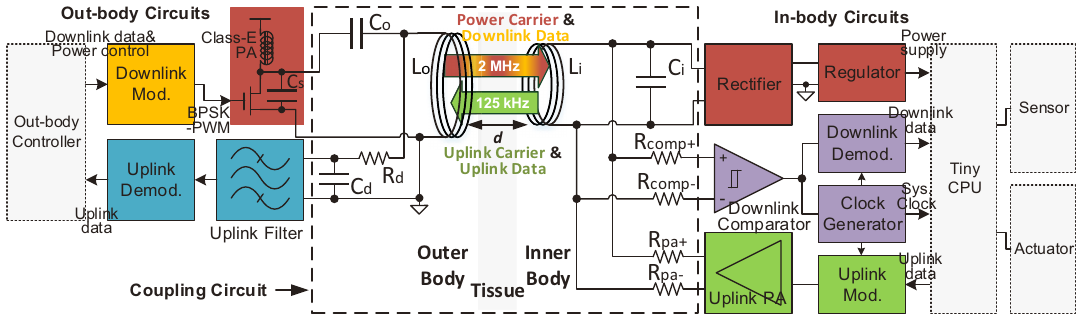
Figure 2. Block diagram of our implantable biomedical sensor system utilizing the proposed inductive link. The WPT and the NFC share the same coil pair by using two carriers. This paper focuses on analyzing and optimizing the inductive link circuit, which is enclosed in the dashed